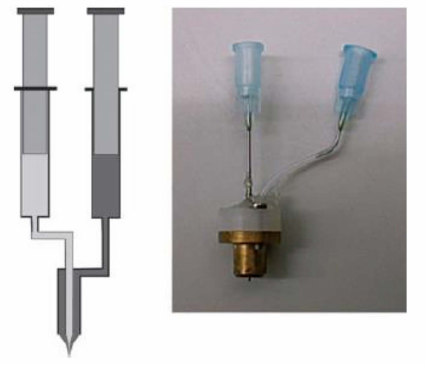
Figure 3. Left: A setup for coaxial electrospinning. Right: The experimental setup for coaxial electrospinning used in the laboratory of A. Greiner and J.H. Wendorff. Reprinted with permission from ref. [3]. Copyright 2007 from John Wiley and